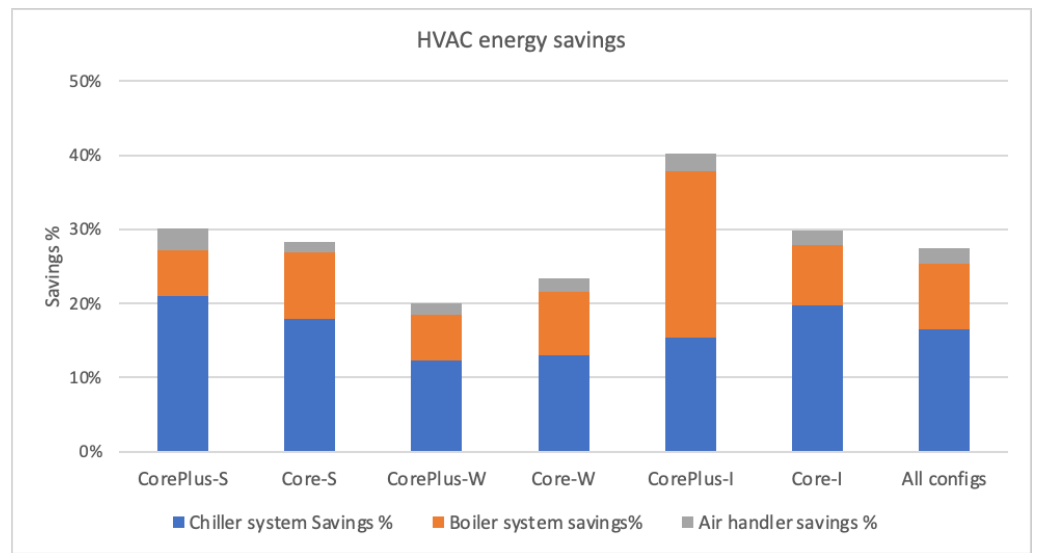
Figure 11. HVAC energy savings for each configuration, broken out by chiller system, boiler system and air handler. Table 5. Thermal load and HVAC energy savings for each configuration.